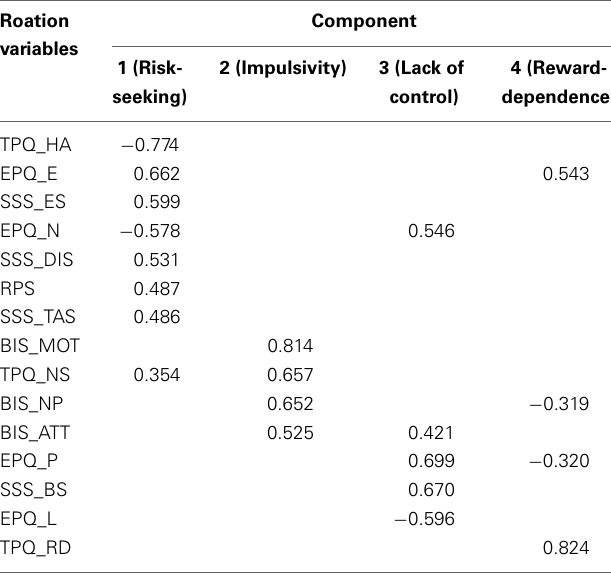
Table 1 | Loadings for principal components using varimax